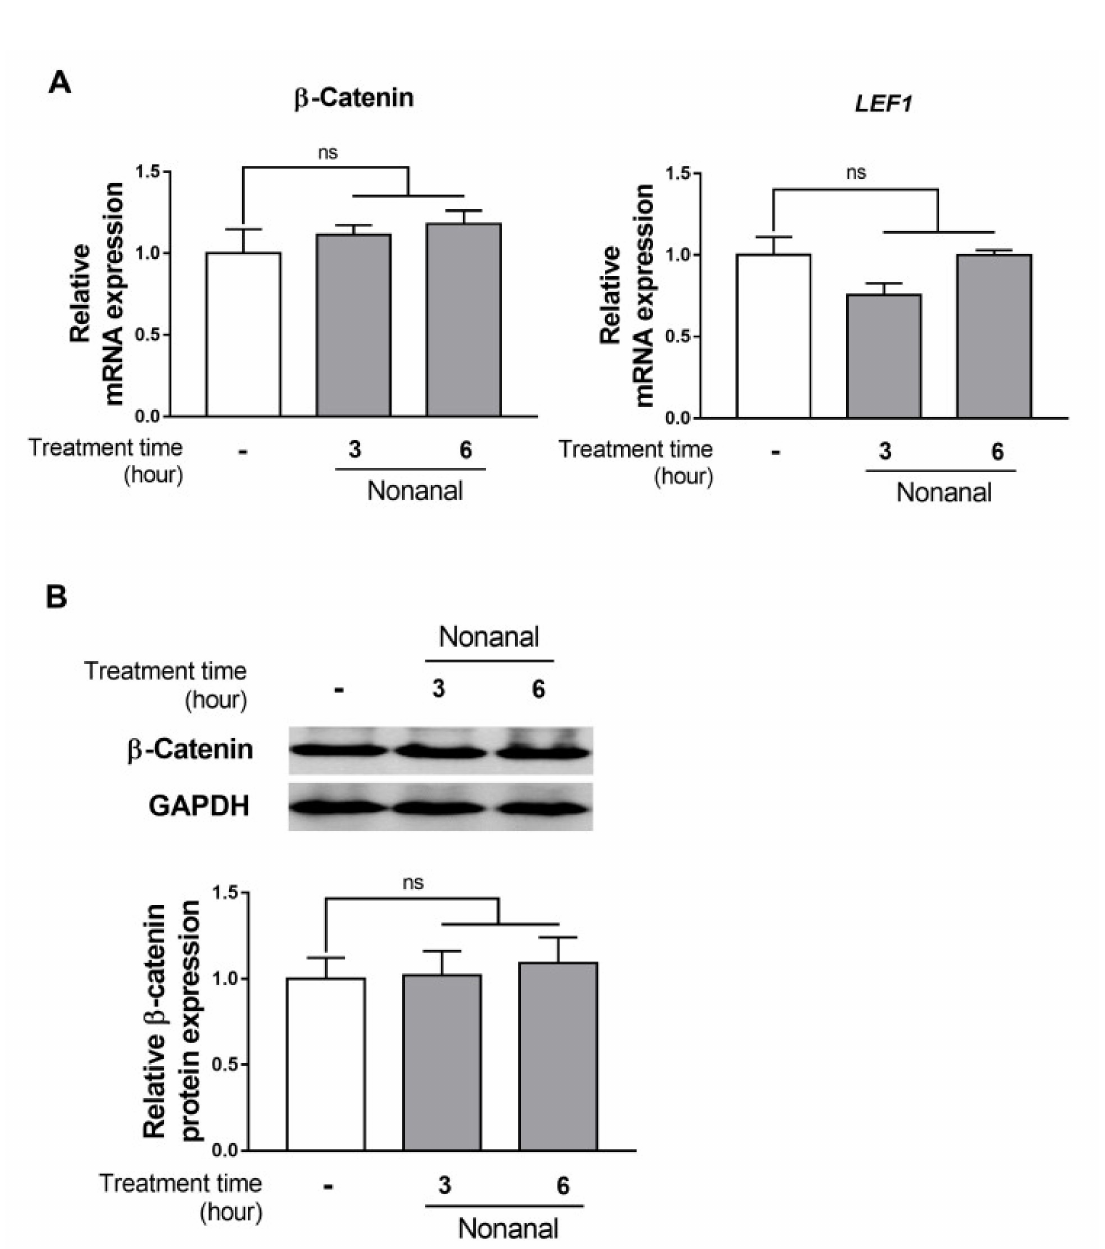
Figure 3. E ff ect of nonanal on β -catenin pathway in DPCs. DPCs were exposed to vehicle or 50 µ M of nonanal at di ff erent time points (3 and 6 h). ( A ) Relative β -catenin and lymphoid enhancer-binding factor 1 ( LEF1 ) mRNA levels were analyzed by real-time PCR. ( B ) β -catenin protein levels were detected by Western blot. Data were statistically analyzed using the Student’s t -test. Data are presented as mean ± SEM of the results of three independent experiments. ns, not